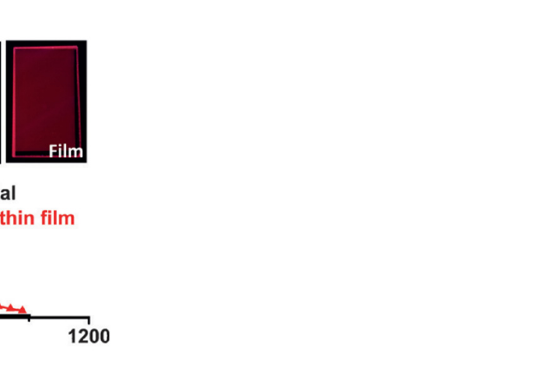
(Figure 22) using a boron difluoride curcuminoid derivative with amplified spontaneous